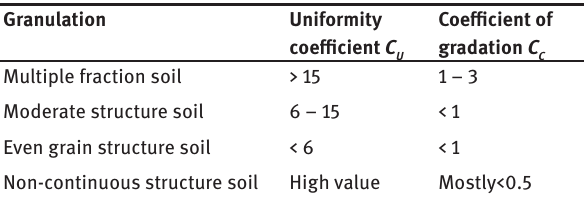
Table 1: Ground characteristic according toPN-ISO14688-2:2006 [4]